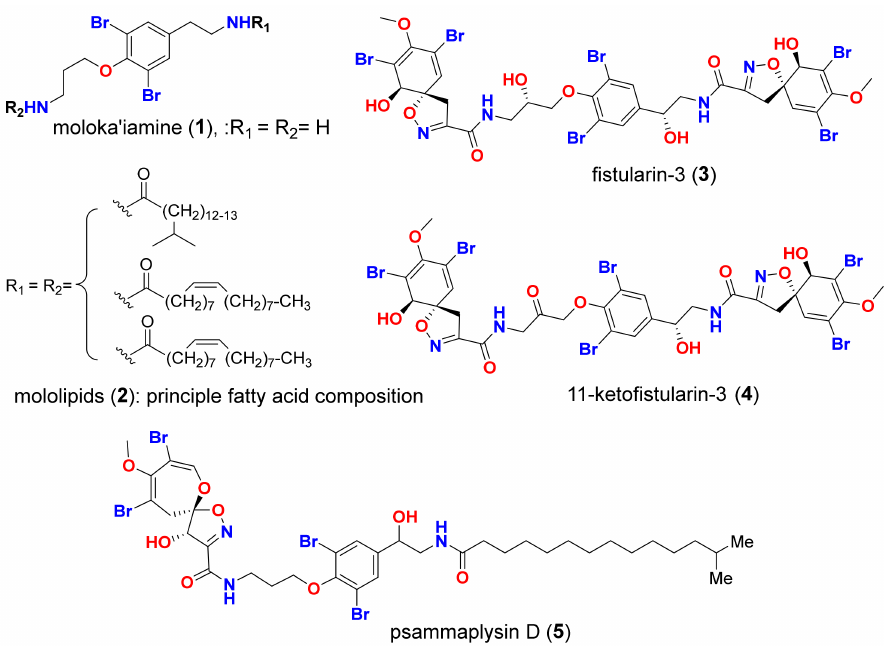
Figure 2. Reported antiviral bromotyrosine compounds 1–5 .